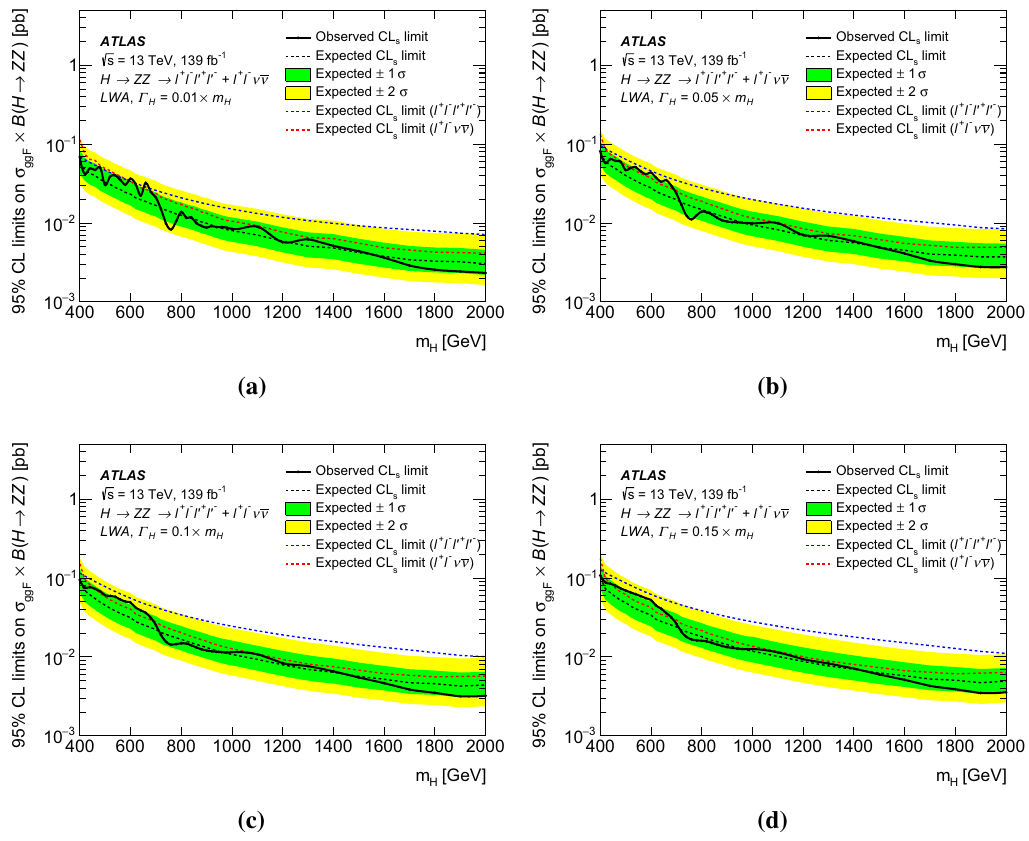
Fig. 5 Theupperlimitsat95%CLonthecrosssectionfortheggFpro- ductionmode timesbranching ratio( σ ggF × B ( H → Z Z ) )as afunction of m H for an additional heavy scalar assuming a width of a 1%, b 5%, c 10% and d 15%, of m H . The black line indicates the observed limit.